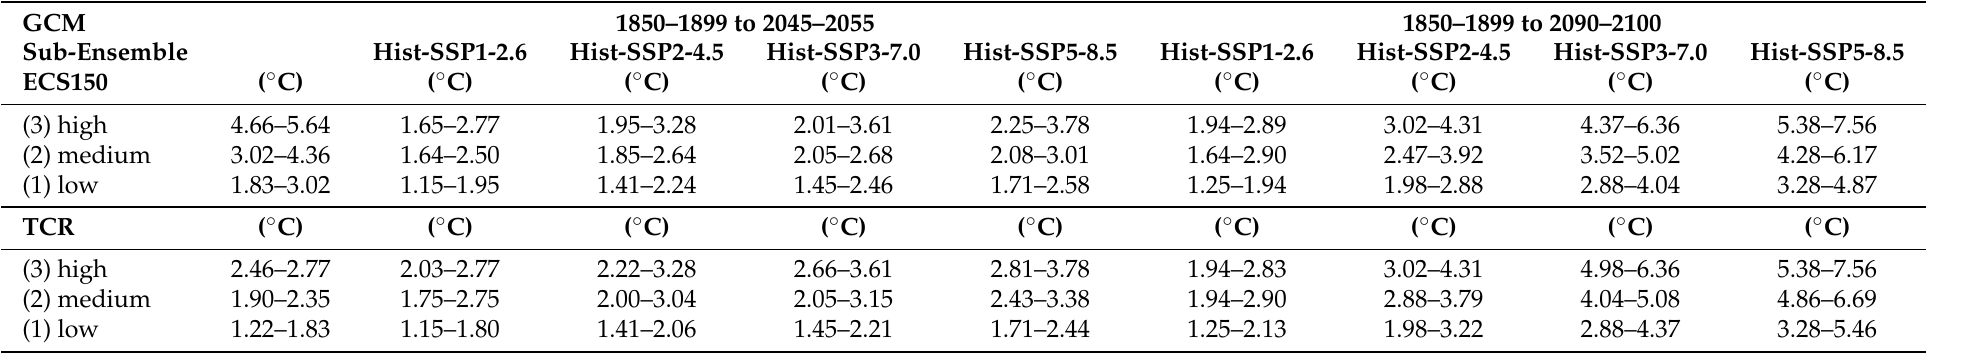
Table A5. Temperature change from 1850–1899 to 2045–2055 and 2090–2100 the CMIP6 Global Circulation Models (GCMs) for three ECS and TCR GCM ensembles and four SSP scenarios. See Figure 4.